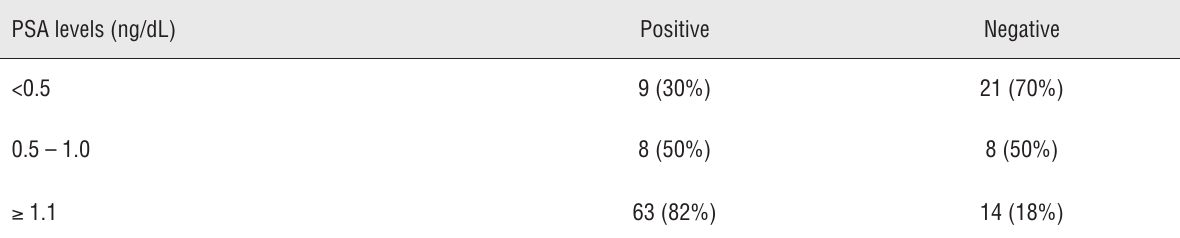
Table 5 - 68 Ga-pSMA pET/cT results according to serum pSA levels (ng/mL) immediately prior to scan. PSA levels (ng/dL) Positive Negative